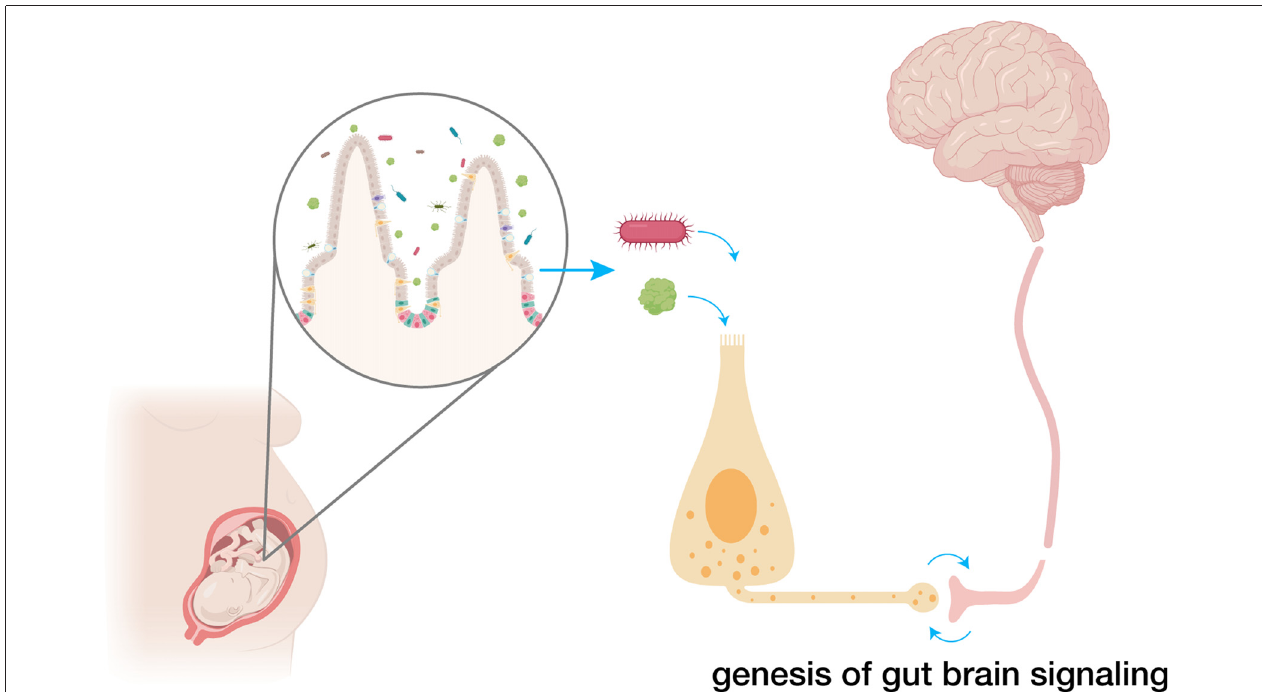
FIGURE 1 | Early exposure to amniotic fluid, nutrients and the microbiota influences gut-brain circuit development. Prior to birth, fetal swallowing exposes its gut to amniotic fluid, containing both nutrients and a developing microbiome. There, nutrients, microbiota and their metabolites come in contact with developing gut sensor cells—enteroendocrine cells—which form synapses with vagal nodose neurons. Dysregulation of the development of this gut-brain neural circuitry can have profound, prolonged effects on later health. Created with